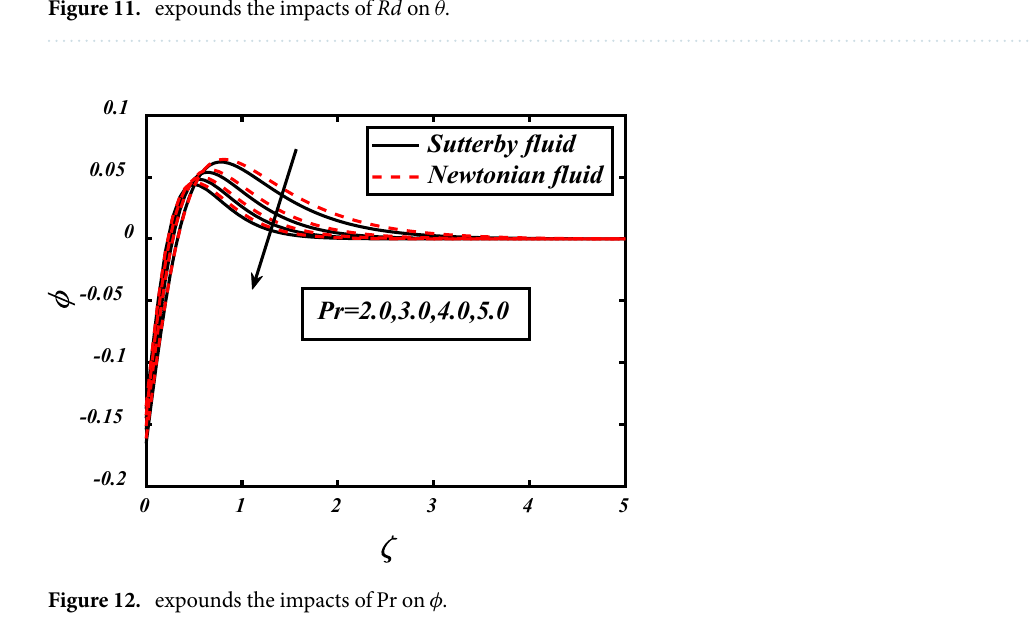
Figure 11. expounds the impacts of Rd on θ .